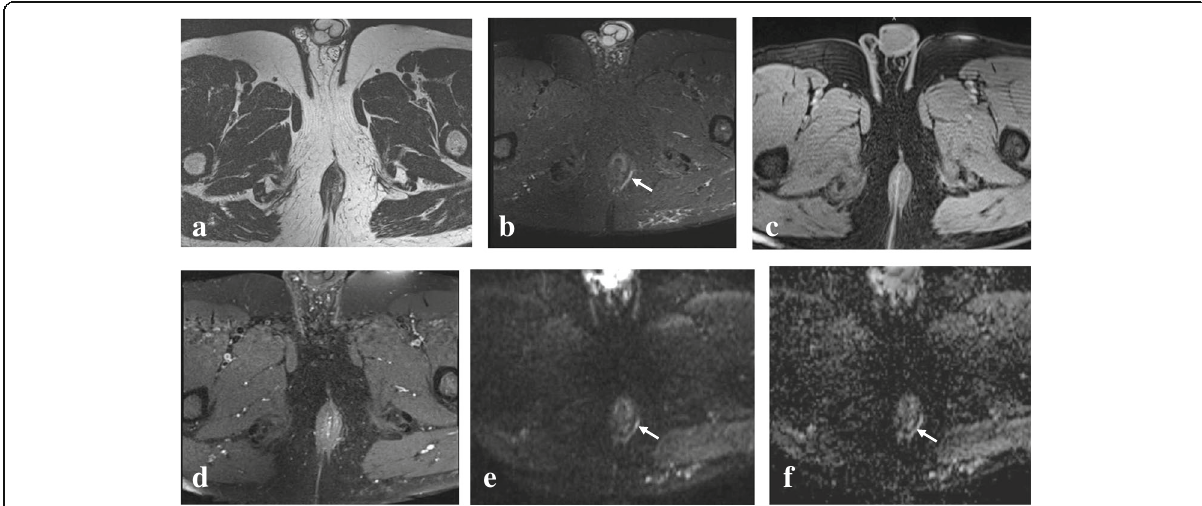
Fig. 5 A 38-year-old man with left inter-sphincteric fistula without abscess. a Axial T2-weighted image, the perianal fistula is not visualized. b Axial STIR-weighted image reveals high signal intensity left perianal fistula (arrow). c Axial T1 fat-saturated weighted image, the perianal fistula is not visualized. d Axial T1 fat-saturated post-contrast injection weighted image, the perianal fistula is not visualized. e Axial diffusion-weighted image reveals high signal intensity of the fistula (arrow). f Axial ADC mapping shows high signal intensity of the fistula (arrow)